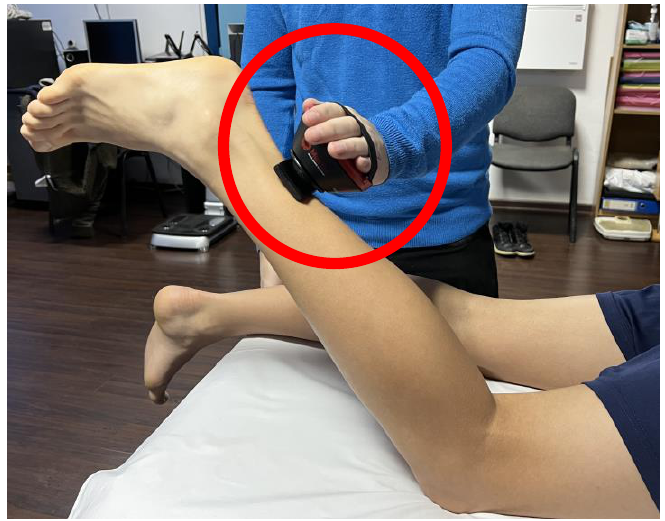
Figure 2. Test of knee flexors.